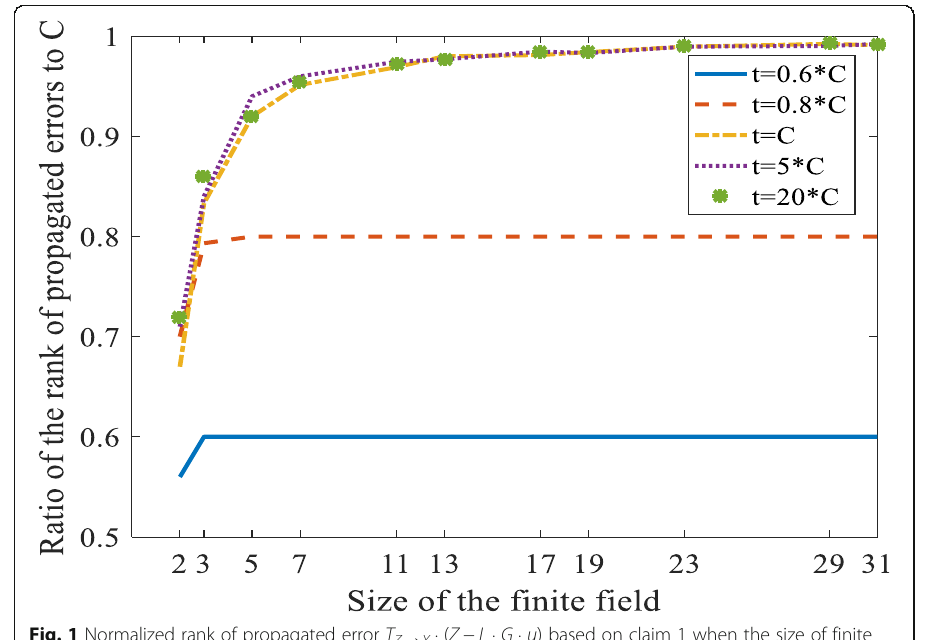
Fig. 1 Normalized rank of propagated error T Z → Y ⋅ ( Z − L ⋅ G ⋅ u ) based on claim 1 when the size of finite . A smaller field size implies a smaller value field is odd. Legend: The vertical axis value is rank ð T Z → Y (cid:3)ð Z − L (cid:3) G (cid:3) u ÞÞ C about normalized rank of propagated error, when t (the number of original error) is